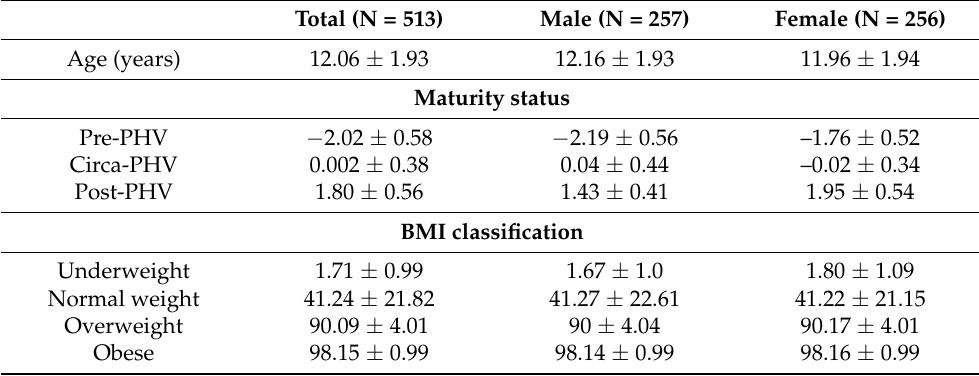
Table 1. Participants’ characteristics (mean ± SD) for the total sample and by sex. Total (N =